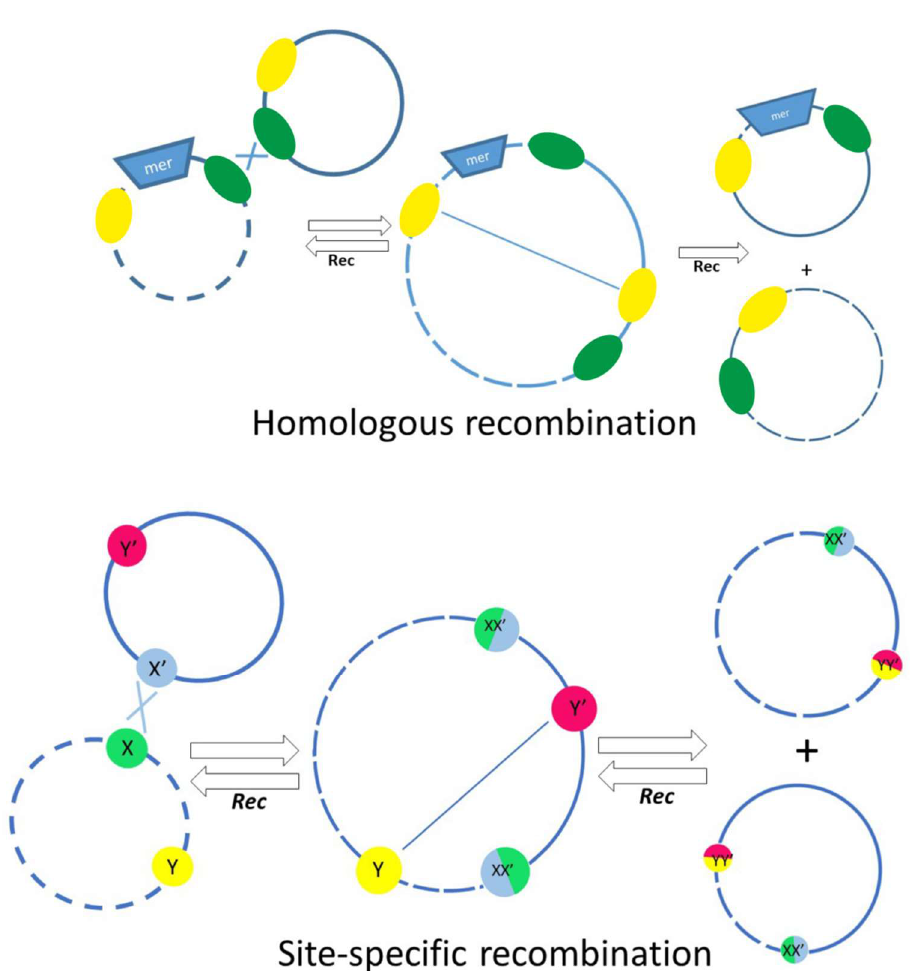
Figure 4. The main mechanisms involved in the exchange of genetic material between plasmids, involving homologous recombination ( top ) or site-specific recombination depending on res sites and the action of resolvases ( bottom ). The res sites are indicated by colored circles in the bottom panel.